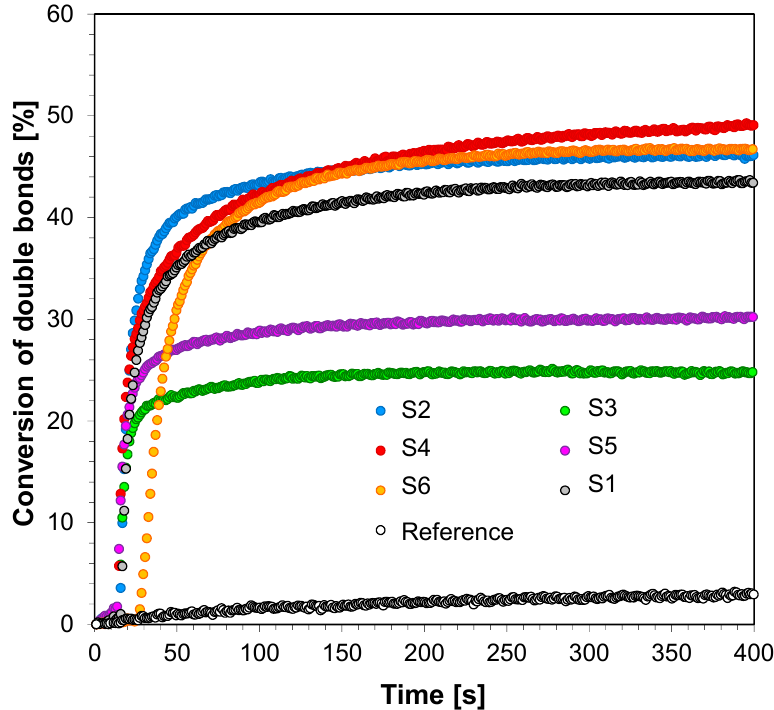
Figure 11. Conversion of double bonds of TMPTA recorded during free-radical photopolymerization with binary initiating system—HIP and fluorescent probes under UV-LED 365 nm (95 mW/cm 2 ) irradiation.